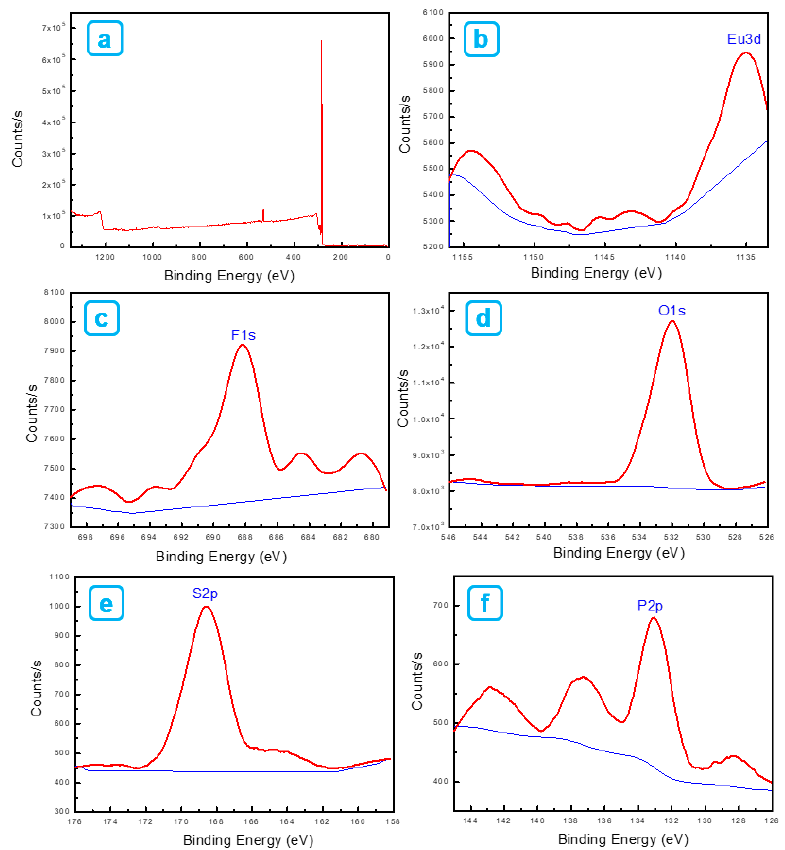
Figure 5. ( a ) X-ray photoelectron spectroscopy survey spectra of Eu(TFTB) 2 (MAA)P(Oct) 3 @poly(St- co -MAA). ( b ) Eu 3d core-level spectrum, ( c ) F 1s core-level spectrum, ( d ) O 1s core-level spectrum, ( e ) S 2p core-level spectrum and ( f ) P 2p core-level spectrum of Eu(TFTB) 2 (MAA)P(Oct) 3 @poly(St- co -MAA).